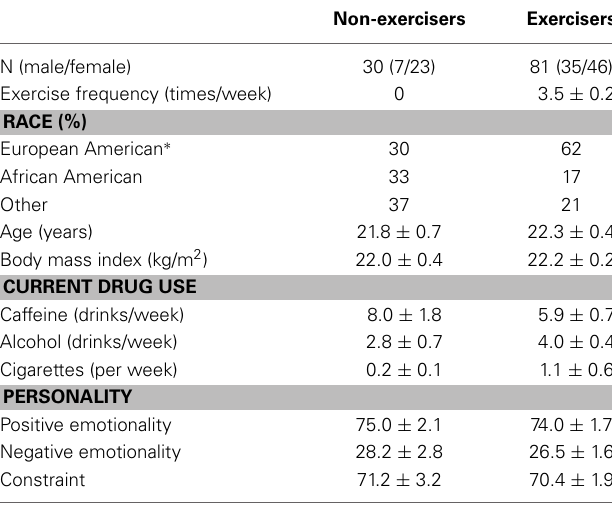
Table 1 | Demographic characteristics of study